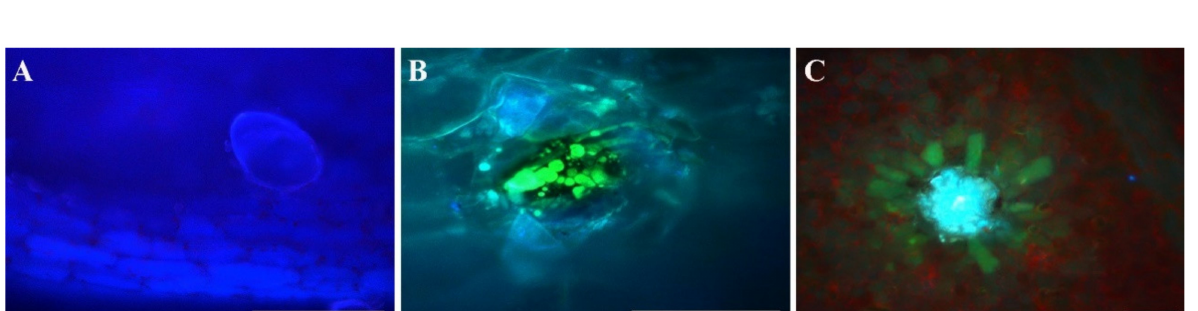
Figure 6. Autofluorescence analysis of epidermal tissue and wax glands from the abaxial leaf surface of M. maritima plants from a jar ( A ), Plantform ( B ) and in vivo plants ( C ). In ( A , C ) bars = 100 µ m; in ( B ), bar = 50 µ